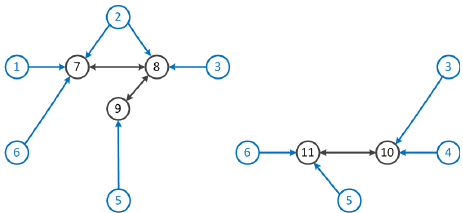
Figure 8. Two connected parts in the unconnected topology.